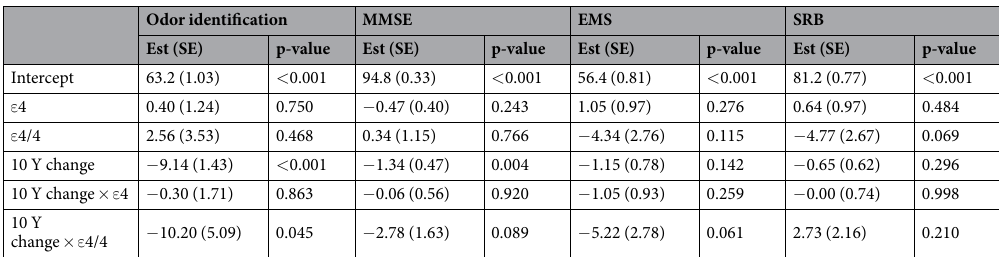
Table 2. Parameter estimates from mixed models of olfactory and non-olfactory cognitive outcomes for middle-aged participants, adjusted for age, sex, education, and previous testing experience (one vs. two times).